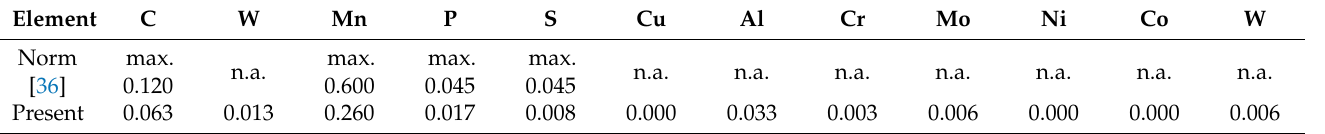
Table 1. Metallic composition of the present low carbon steel CR4 in comparison to the standard